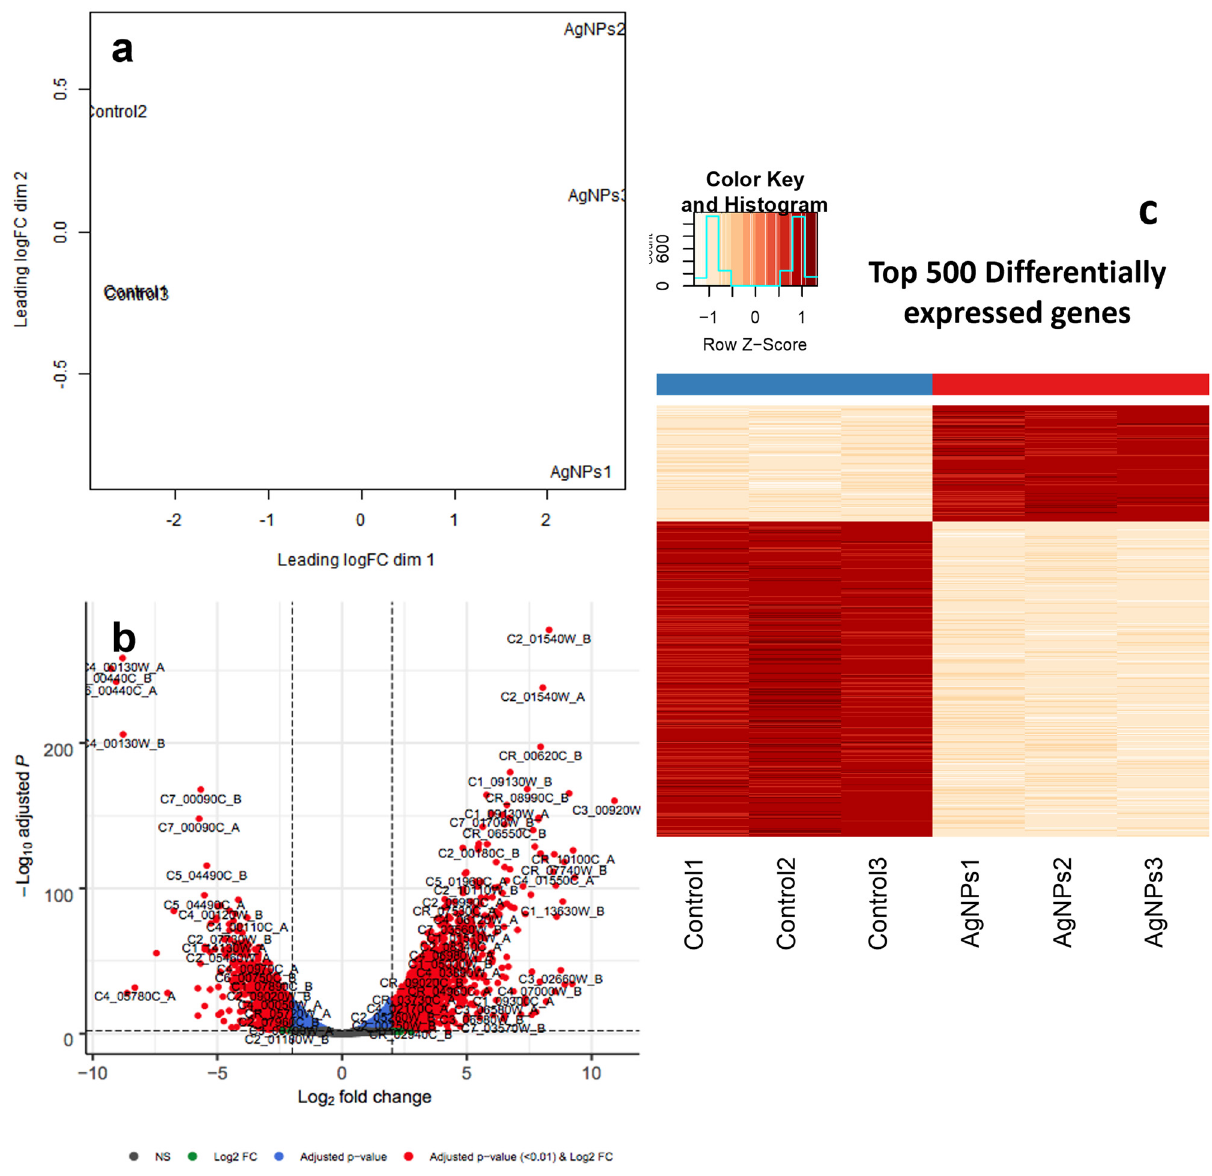
Figure 8: Transcriptome analysis of C. albicans by RNA - seq. ( a ) Multidimensional scaling plot, which determines the most signi fi cant data variation sources. ( b ) Volcano plots that correspond to the di ff erentially expressed genes. Upregulated genes ( red dots - right ) , down - regulated genes ( red dots - left ) , no signi fi cant di ff erential expressed genes ( black dots ) . ( c ) Heat map of 500 di ff erential gene expressions between the control group ( C. albicans without AgNPs treatment ) and experimental group ( C. albicans treated at 25 µg · mL − 1 )